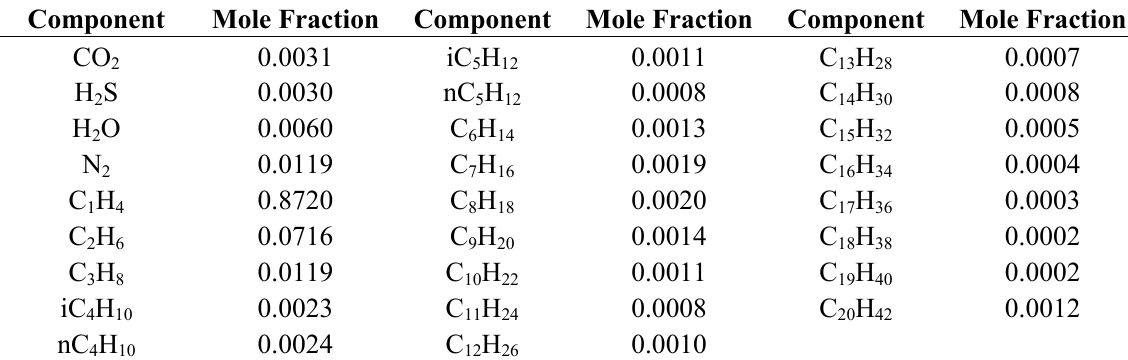
Table 1. Composition of DINA24 condensate